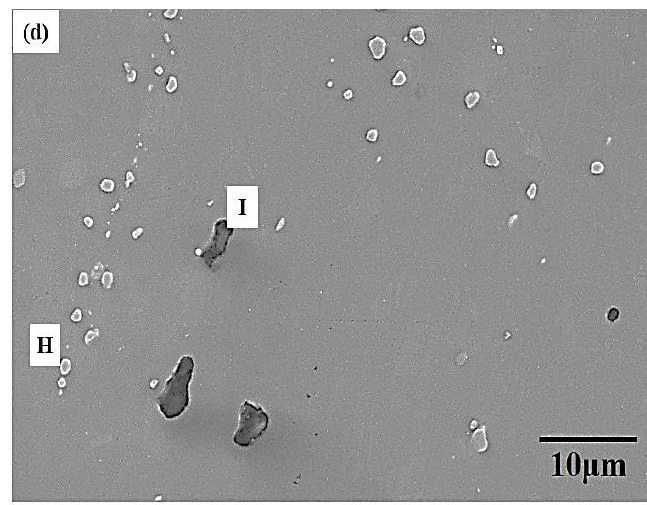
Figure 9. The morphology and the distribution of the 7075 aluminum alloys after FSP and various heat treatments: ( a ) BM-O specimen, ( b ) BM-W specimen ( c ) 440-NA specimen, ( d ) 440-W Table 3. EDS data for specimens shown in Figure 9 (Unit: at. %).